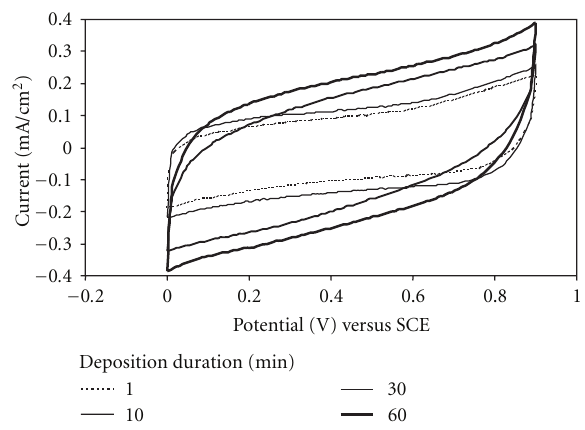
Figure 6: Cyclic voltammograms of self-assembled manganese dioxides thin films deposited at di ff erent submersion durations.